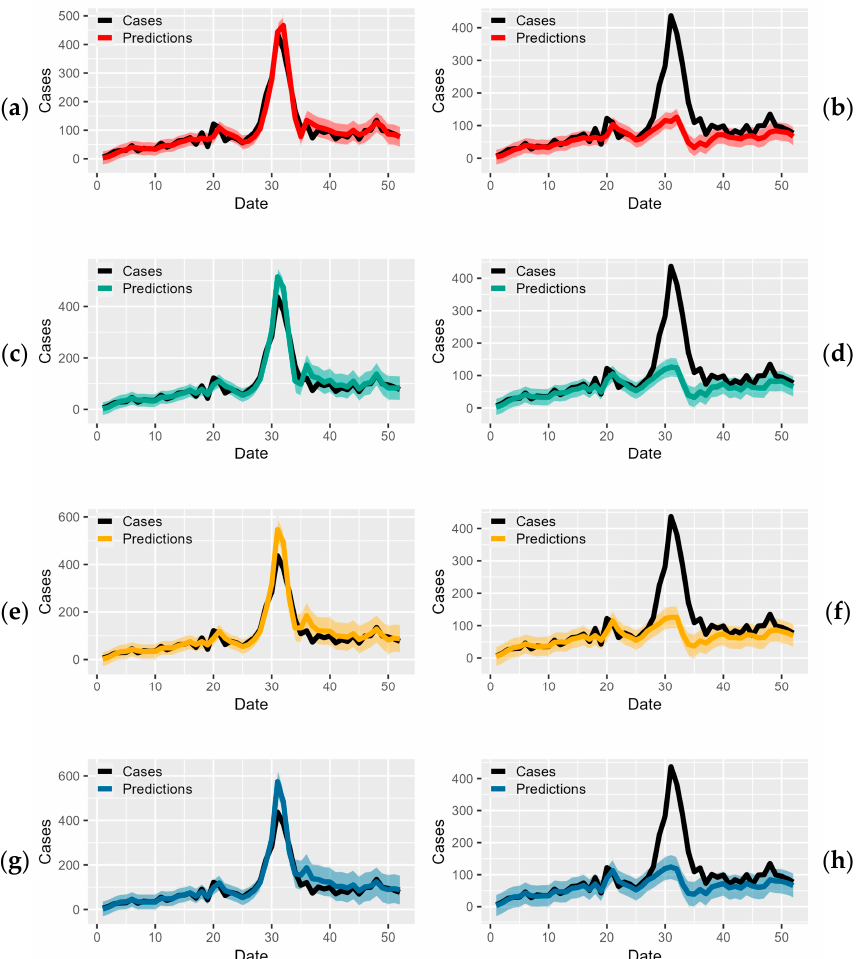
Figure 2. Predictions of HFMD compared to actual HFMD cases; ( a ) actual against 1-week advance